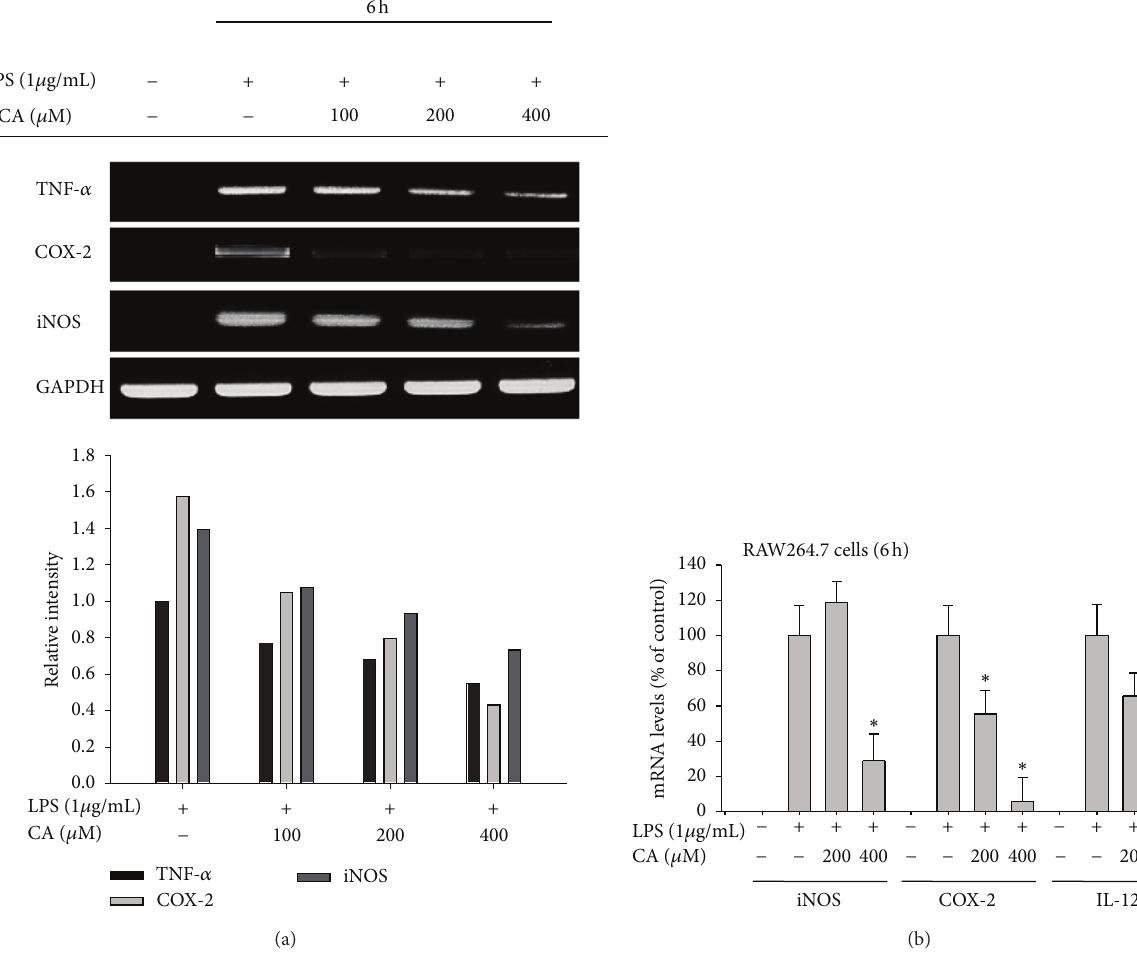
Figure 2: Effect of CA on the expression of proinflammatory gene mRNA. ((a) and (b)) mRNA levels of the genes encoding iNOS, TNF- 𝛼 , IL-12, COX-2, and GAPDH were determined by semiquantitative or quantitative PCR. Relative intensity was calculated using GAPDH level by the DNR Bioimaging system. ∗ 𝑃 < 0.05 , compared to the